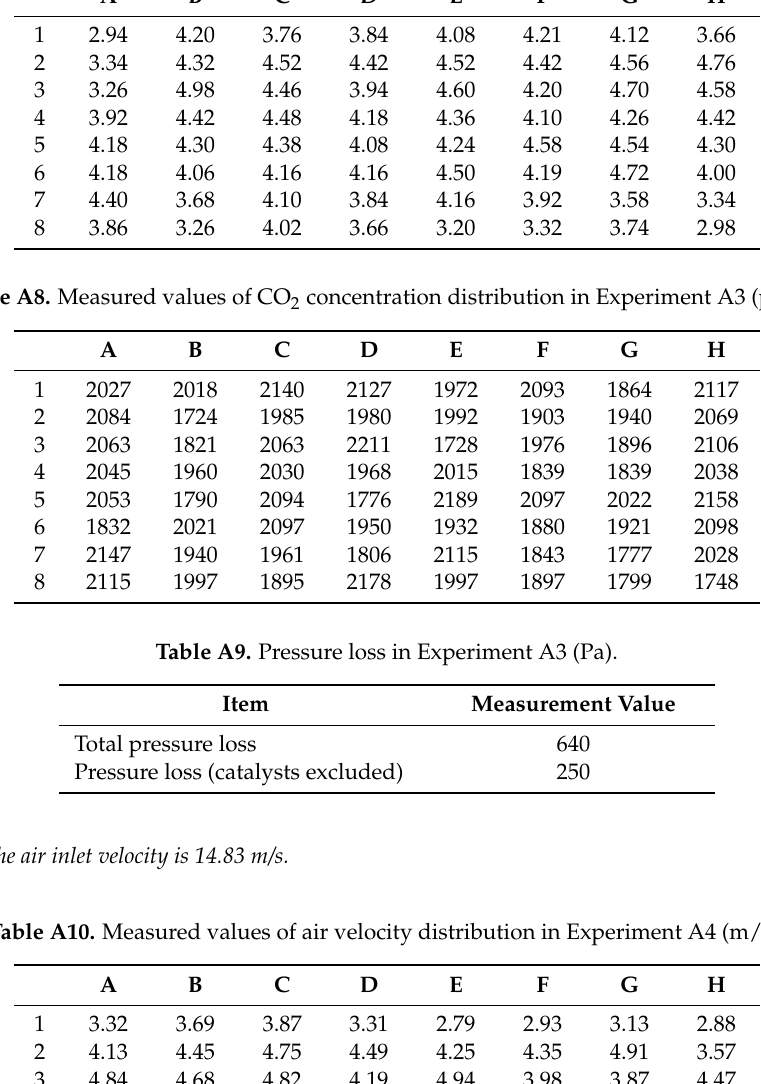
Table A7. Measured values of air velocity distribution in Experiment A3 (m/s).